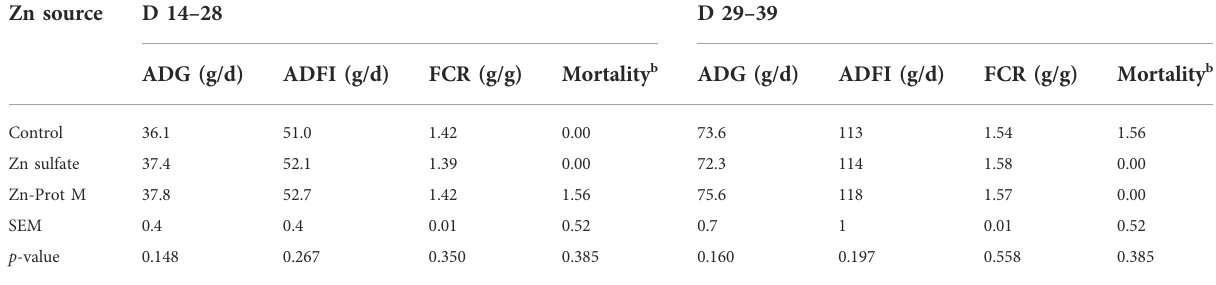
TABLE 4 Effect of dietary Zn source on growth performance and mortality of broilers a .